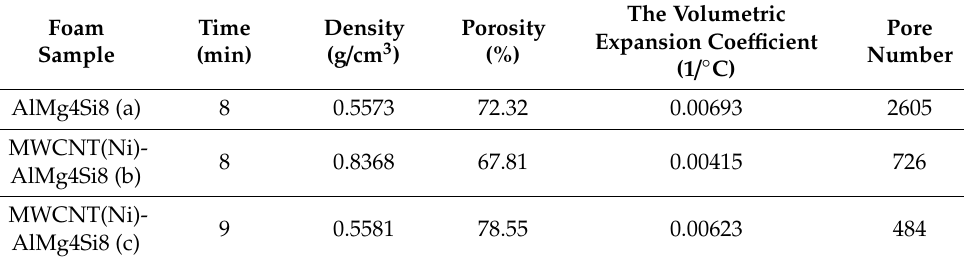
Table 2. Structure of the produced aluminum foam.